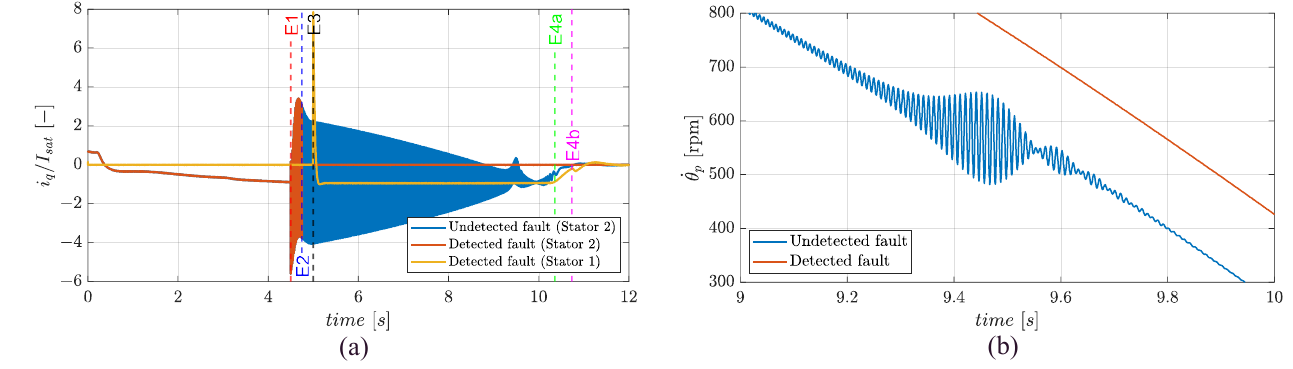
Figure 17. FEPS response in flight termination/landing with phase-to-ground fault on stator 2 (E1, E2, E3 and E4 defined in Section 3.1): quadrature currents ( a ) with I sat = 46 Arms, propeller speed ( b ).